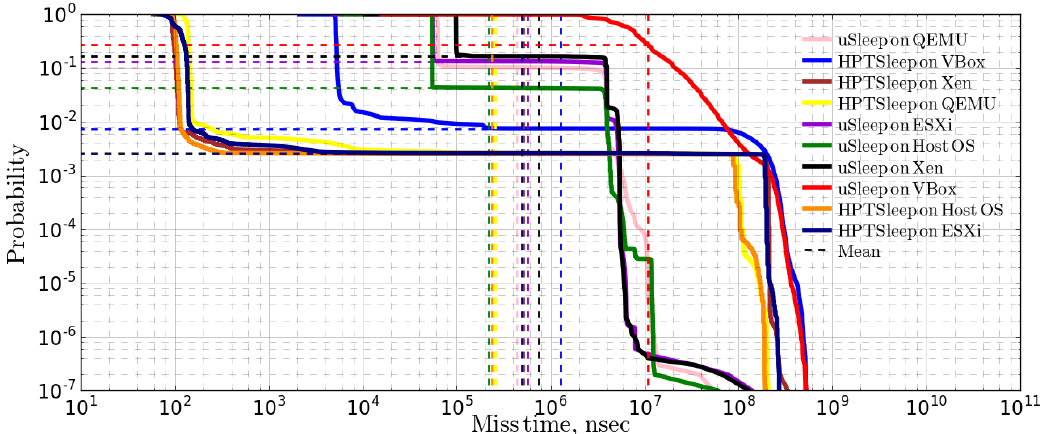
Figure 13. CCDF representation of measurements of miss time for the CPU testbed.